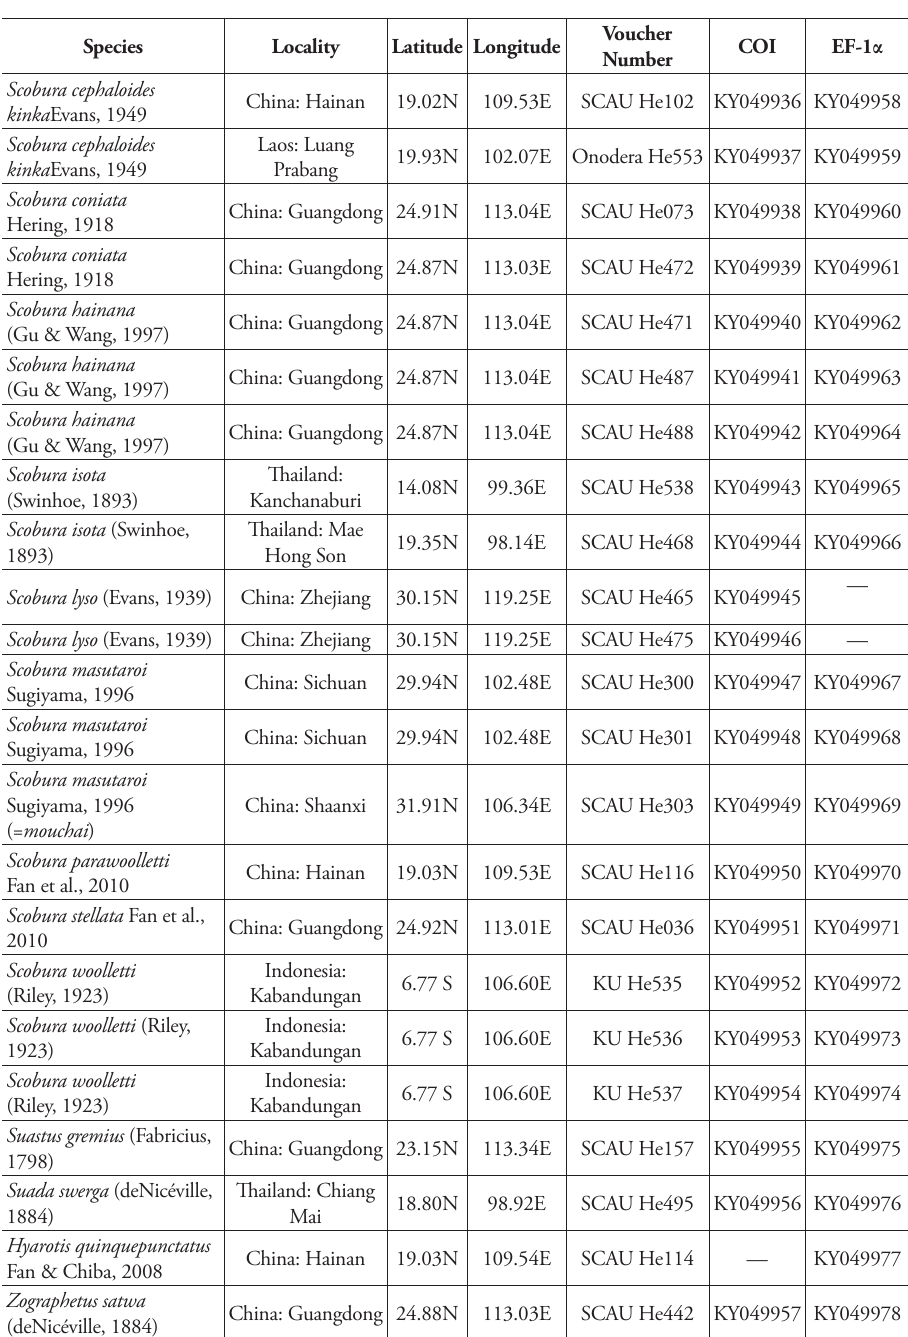
Table 1. Voucher information and GenBank accession numbers for the specimens in this study. Species Locality Latitude Longitude